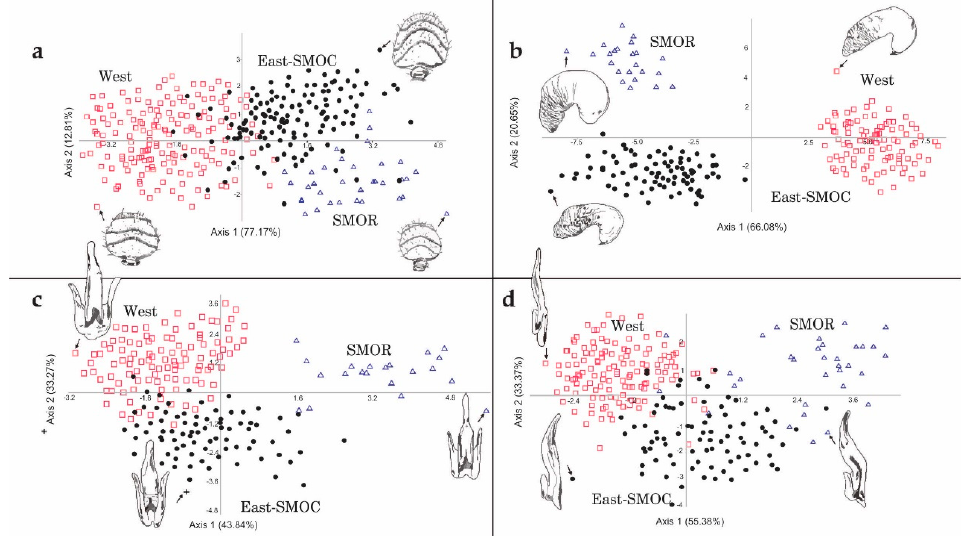
Figure 5. Scatter plots of first and second relative warps in the principal components analysis among D. brevicomis specimens: ( a ) Females–males antennae, ( b ) spermathecae, and ( c , d ) seminal rod in lateral and dorsal view.